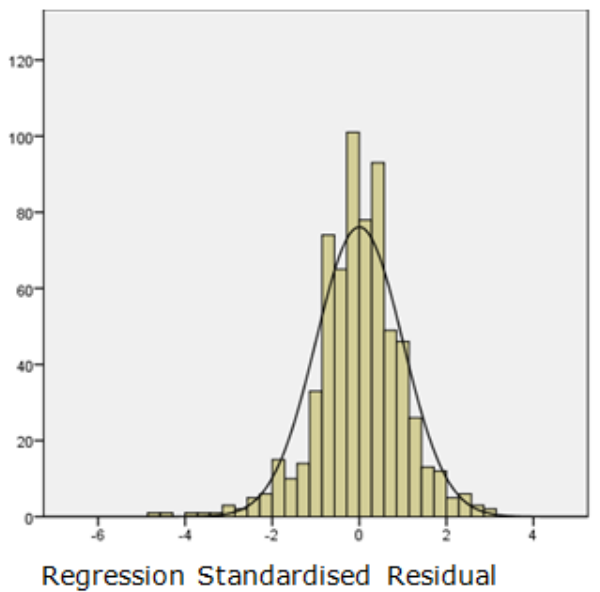
Figure 1. Histogram- Normality of dependent